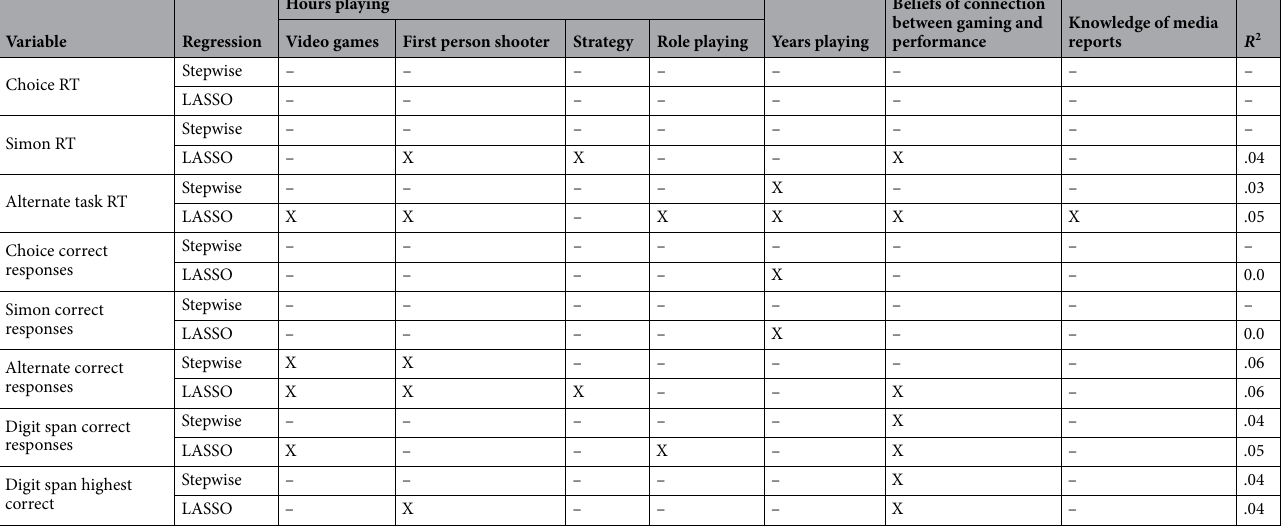
Table 1. Results of stepwise and LASSO regressions (X represents a predicting variable).